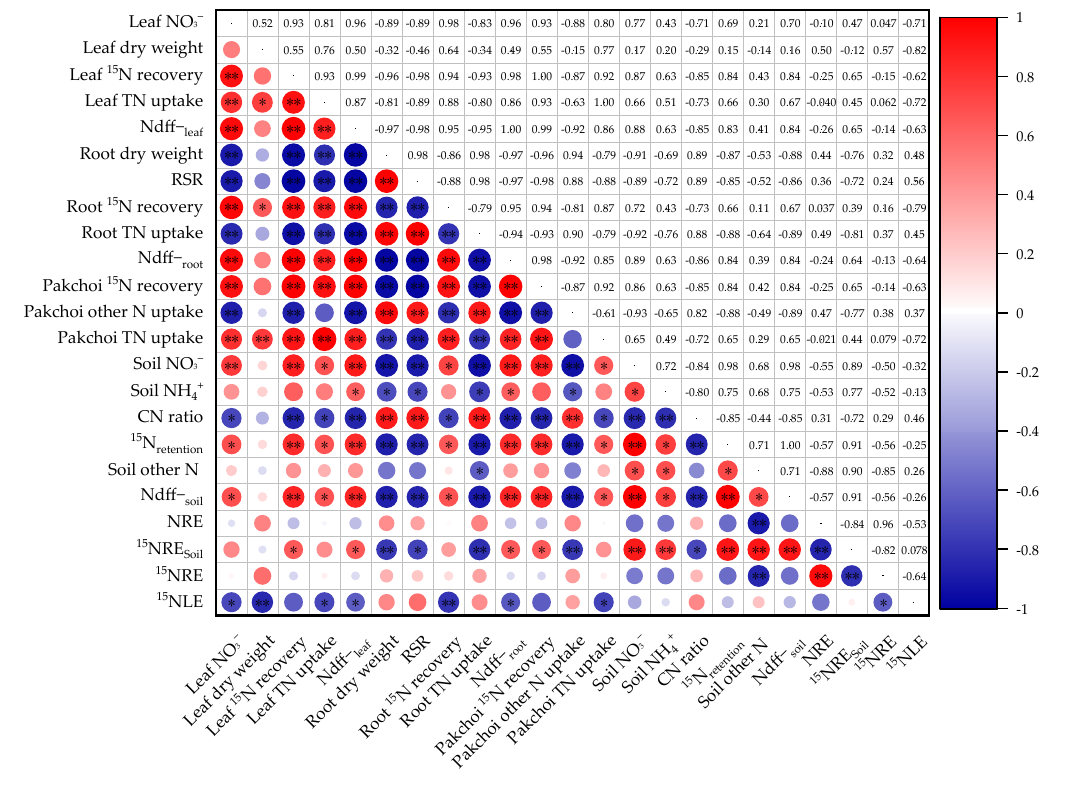
Figure 7. Correlation between the measured indicators. Note: Ndff means N derived from fertilizer; RSR means root crown ratio; CN ratio means the ratio of total carbon to total nitrogen in soil; NRE means N recovery efficiency; 15 NRE means plant 15 N recovery efficiency; 15 NRE soil means soil 15 N retention efficiency; 15 NLE means potential 15 N loss efficiency. The figure shows the correlation between the measured indicators. * and ** indicate a significant correlation at p < 0.05 and p < 0.01, respectively. The colors and numbers indicate the degree of correlation between the corresponding row comment and column comment, red is a positive correlation, and blue is a negative correlation.